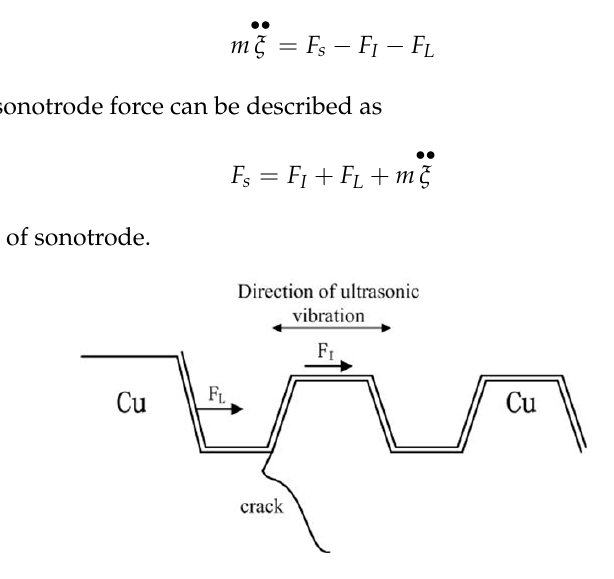
Figure 9. Overview of the forces acting at the sonotrode.